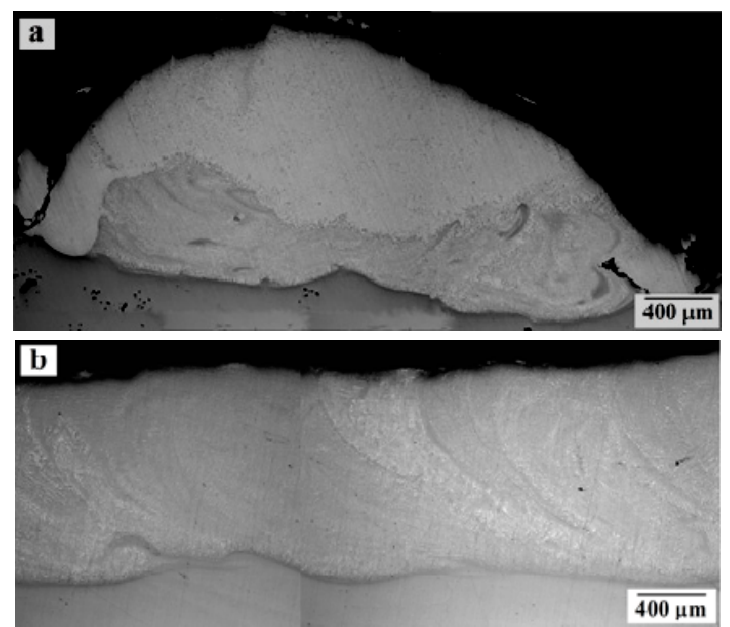
Figure 2. Coating profiles according to optical microscopy for samples: ( a ) No. 2 and ( b ) No. 5.